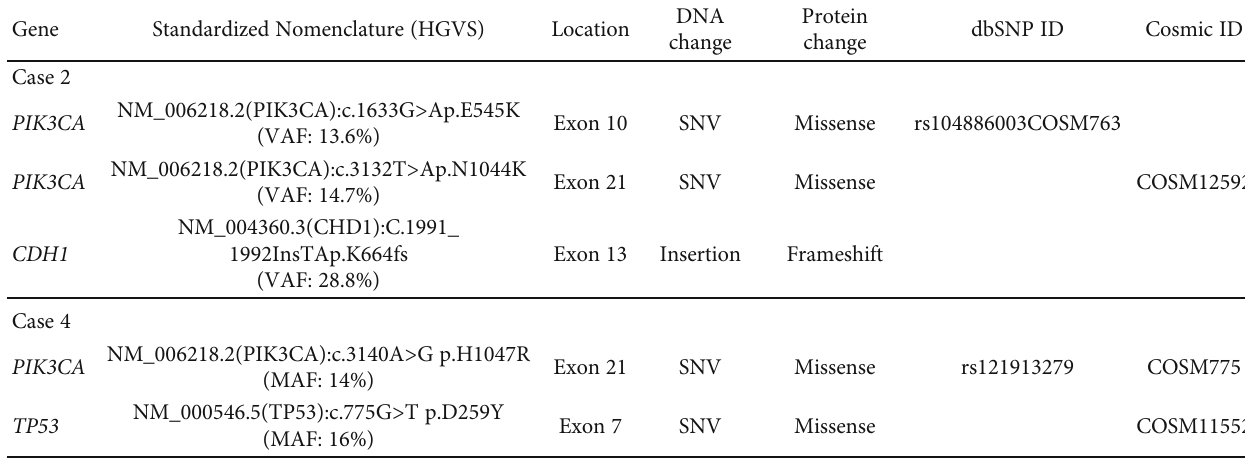
Table 3: Summary of somatic mutations of cases 2 and 4. Standardized Nomenclature